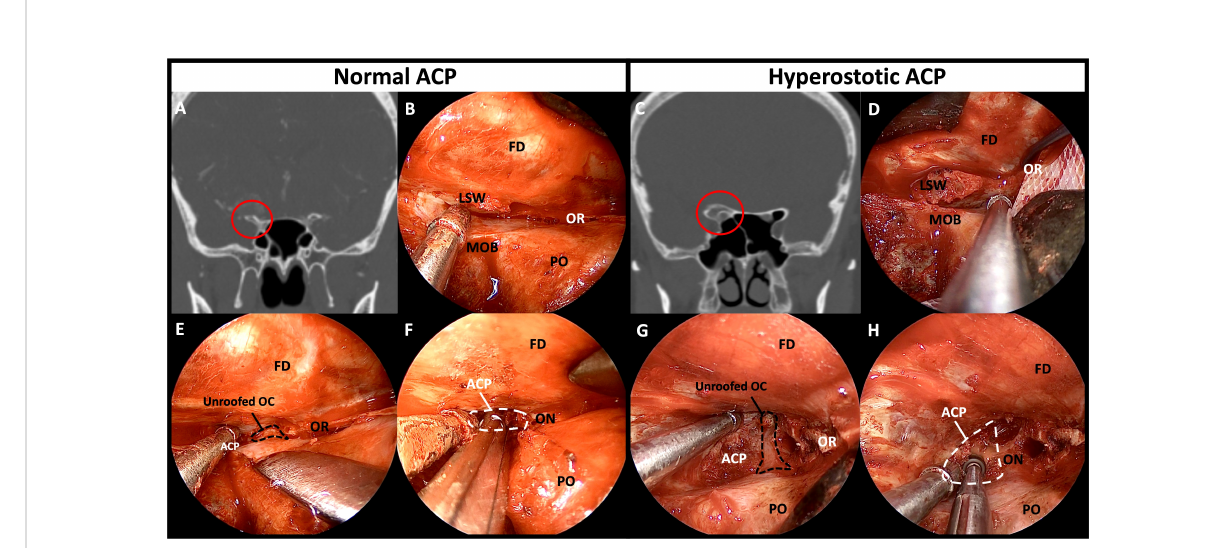
FIGURE 5 Comparison of bony structures between non-hyperostotic ACP and hyperostotic ACP. (A) Coronal image of preoperative CT of the patient with non-hyperostotic ACP. (B) Normal anatomy of the thin LSW and orbital roof. (C) Coronal image of preoperative CT of the patient with hyperostotic ACP. (D) Hyperostosis induced thickening of the LSW and the orbital roof. (E) Thin roof of the optic canal opened by fracturing or rongeuring using forceps. (F) The ACP removed by manipulation and fracturing the optic strut. (G) Drilling the bony roof of the optic canal using a small diamond drill tip for unroo fi ng. (H) Drilling the ACP center and hyperostotic optic strut for facilitating removal of the ACP. ACP, anterior clinoidal process; CT, computed tomography; FD, frontal dura; LSW, lesser wing of sphenoid bone; MOB, meningo-orbital band; OC, optic canal; ON, optic nerve; OR, orbital roof; PO,